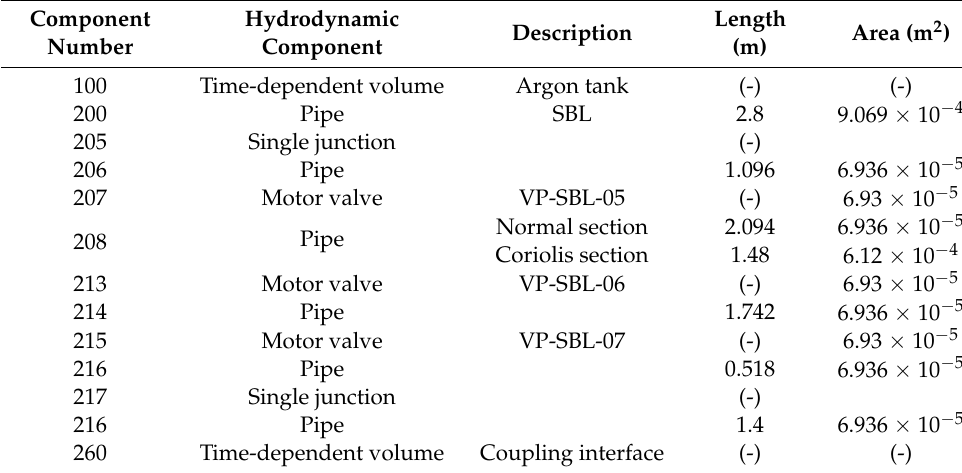
Table 6. Characteristics of RELAP5/Mod3.3